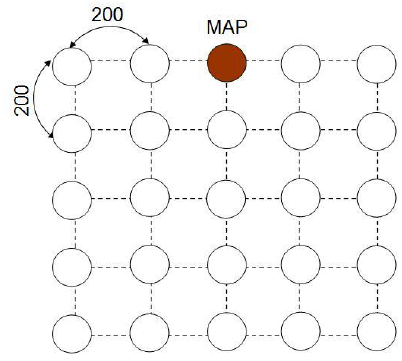
Figure 4. Experimental environment (5  5).